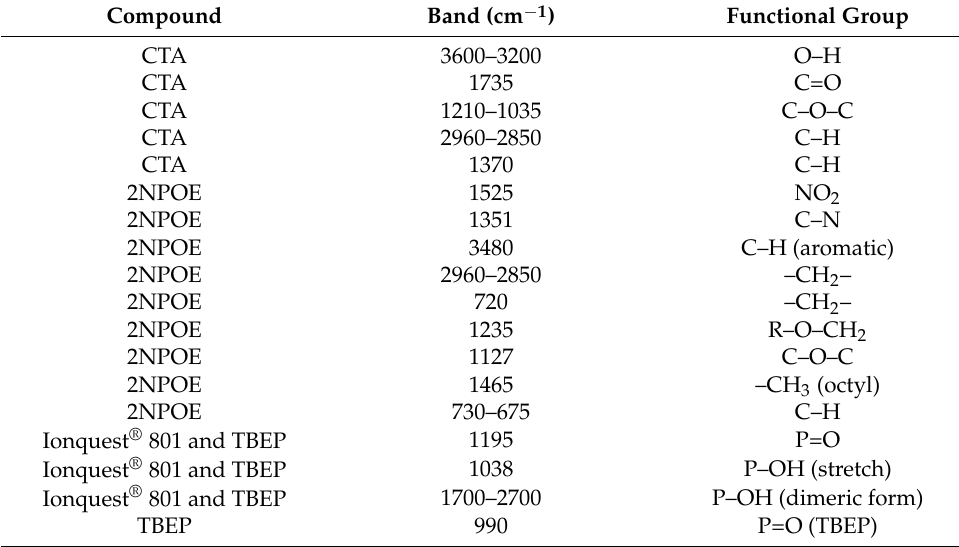
Table 5. Characteristic FTIR vibrations and the corresponding functional groups of the compounds present in the prepared PIMs.